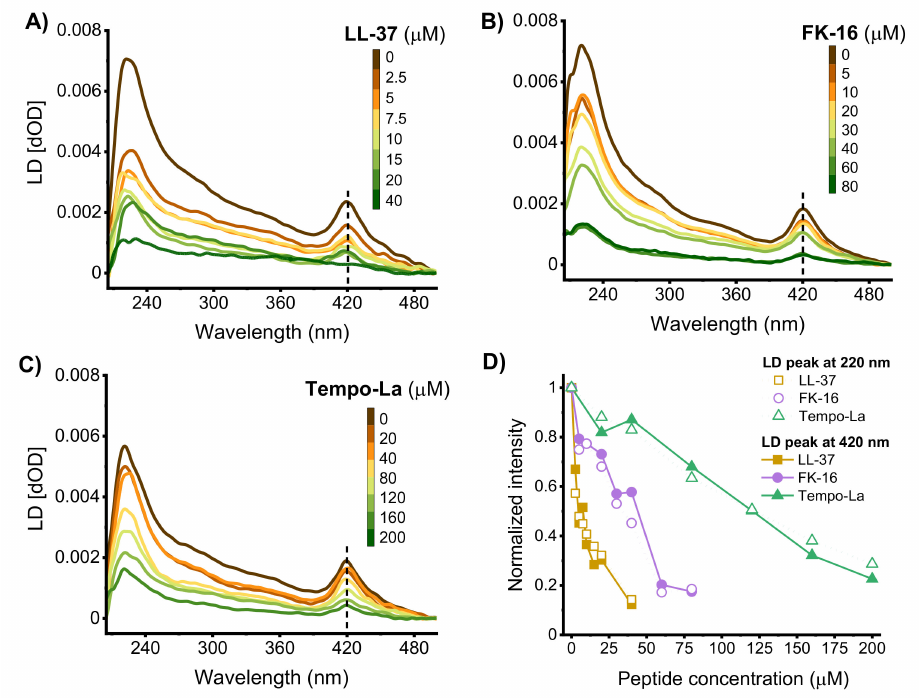
Figure 7. REV-ACP interactions studied by LD spectroscopy. The Soret band in the LD spectra of REVs is indicative on how ACPs interact with the surface of the vesicular bilayer. LD spectra of REVs upon addition of ( A ) LL-37, ( B ) FK-16, and ( C ) Tempo-La. ( D ) LD peak intensity at 420 nm (close symbols) and at 220 (open symbols) as a function of the ACPs. Data are normalized to values measured in the absence of